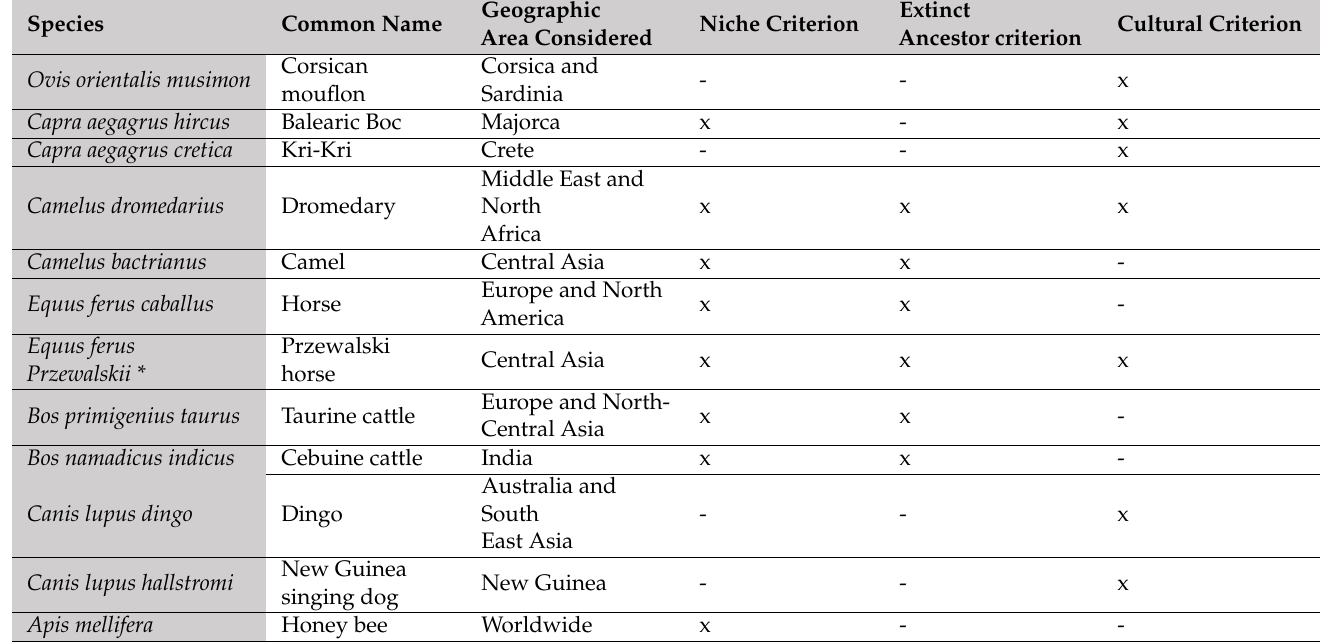
Table 1. Selected feral populations of different taxa with conservation interest following different criteria: (a) Niche criterion (provision of ecosystem services), (b) extinct ancestor criterion (mainte- nance of unique genomic traits), and (c) cultural criterion (attribution of local or global socioeconomic value). * There is a current debate around the feral or wild origin of this taxon